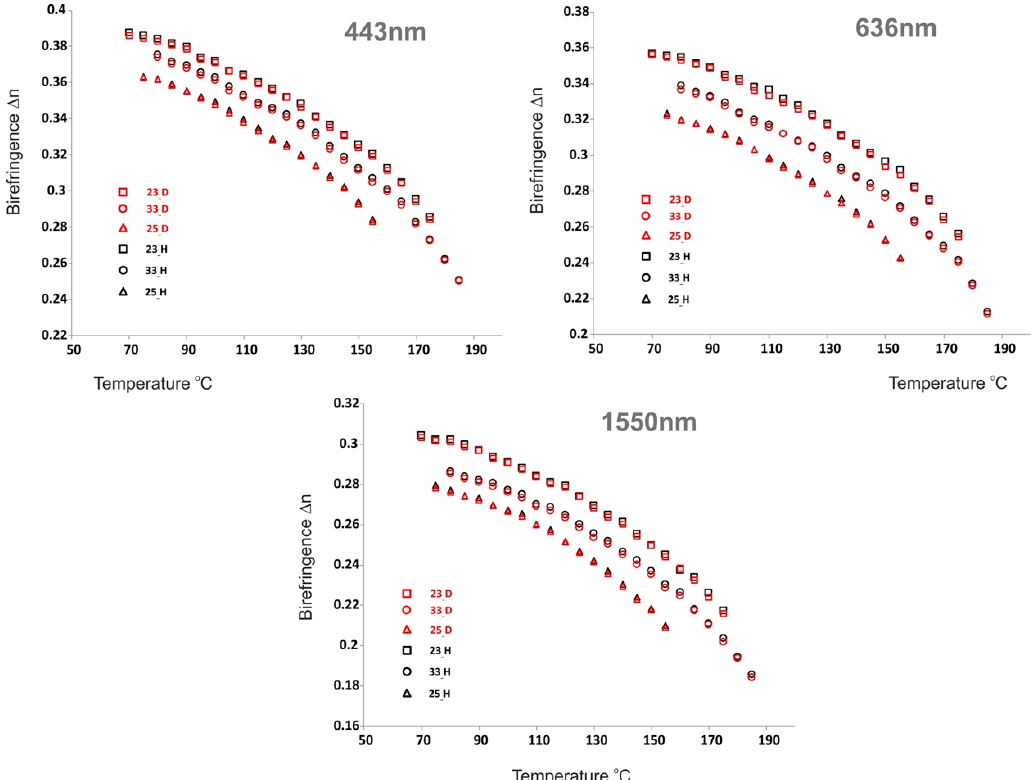
Figure 4. Temperature dependence of birefringence measured for 23 _ H , 33 _ H , 25 _ H , 23 _ D , 33 _ D , and 25 _ D at λ = 443, 636, and 1550 nm.